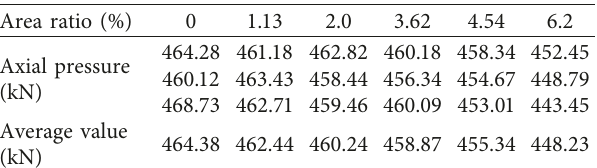
Table 3: Test axial pressure data of specimens with different contents of resin.